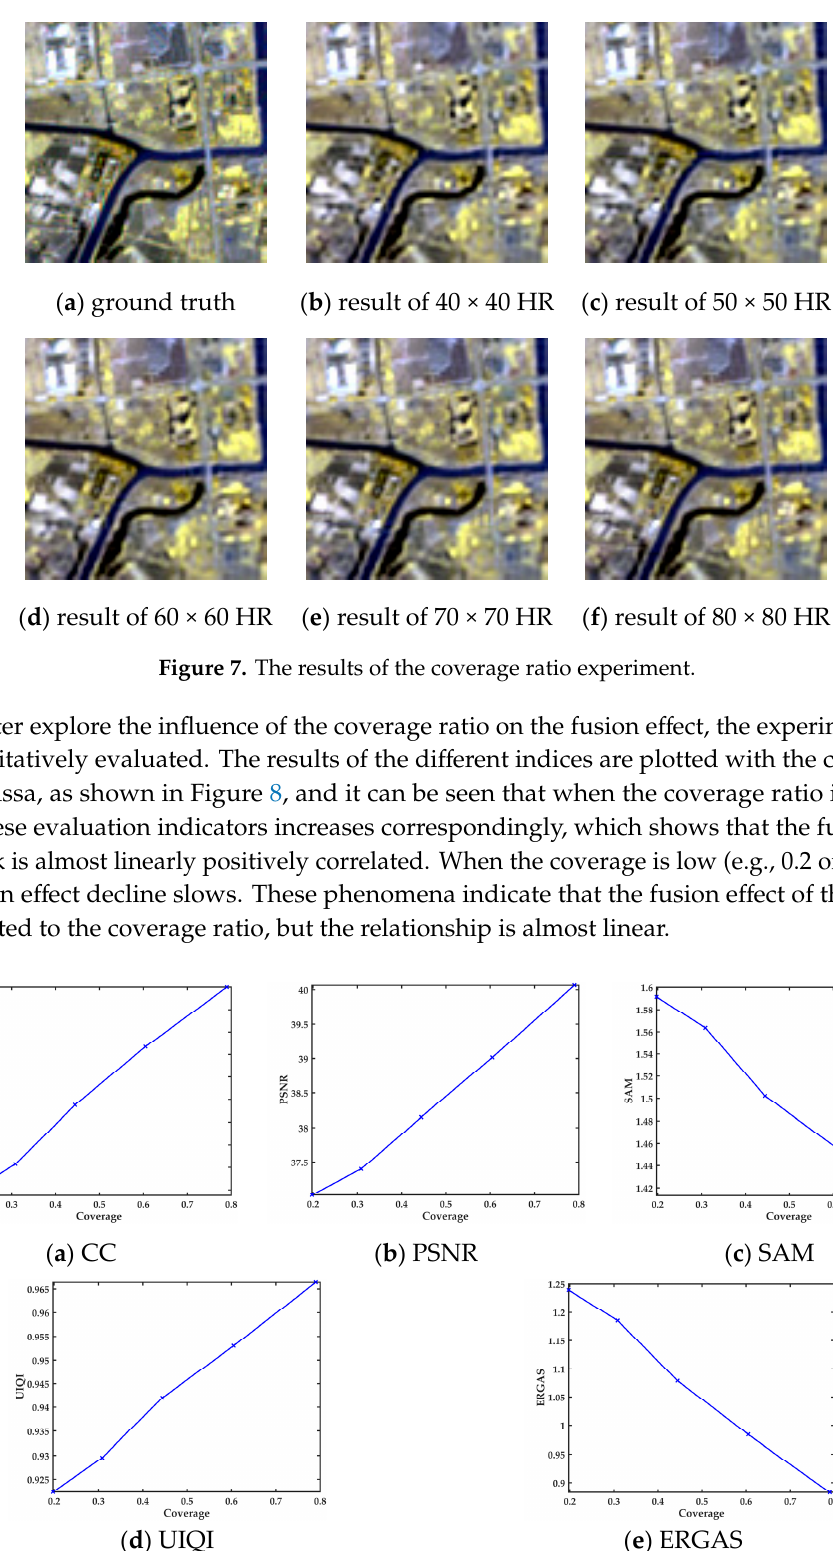
Figure 8. Quantitative evaluation results for different offset positions.